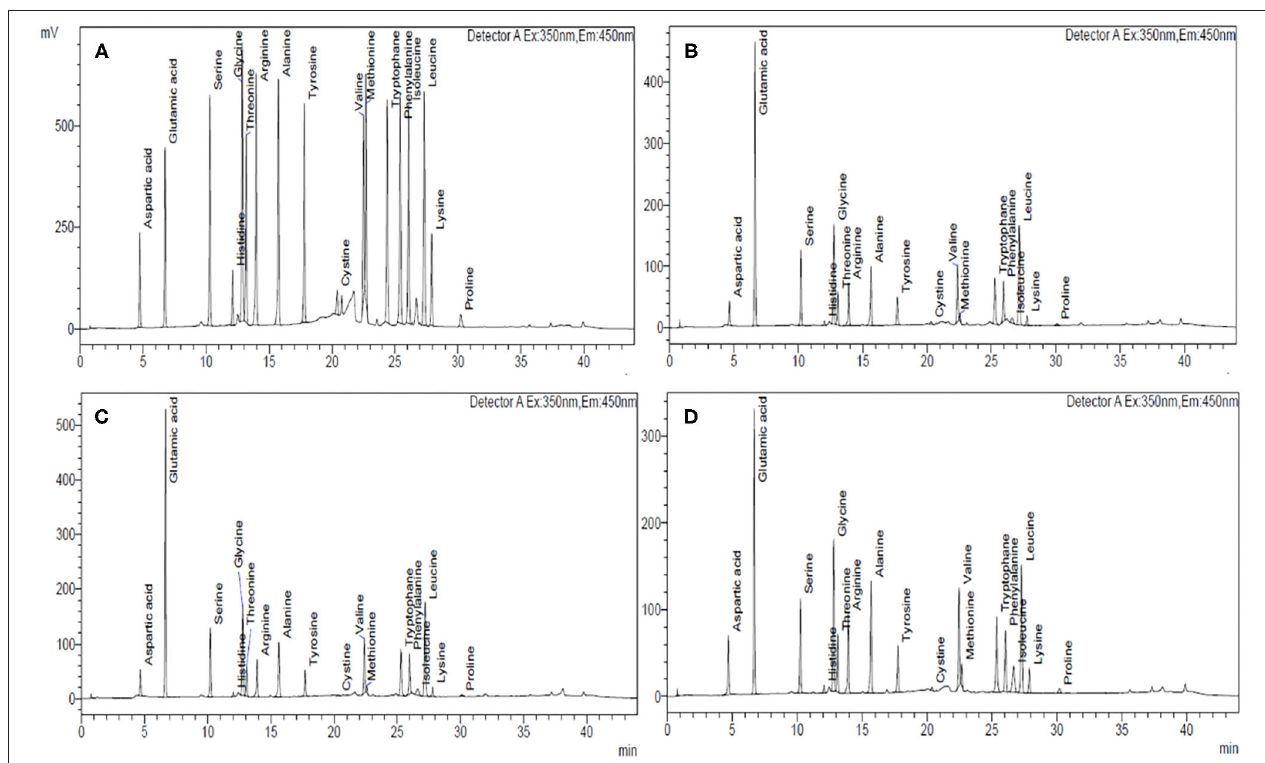
FIGURE 2 | HPLC chromatograms of different cereal flours showing the amino acid composition of (A) standard mixture of 18 amino acids, 500 mmol L − 1 ; (B) wheat, HPW-42, (C) rye, MCTLG-1, and (D) barley,